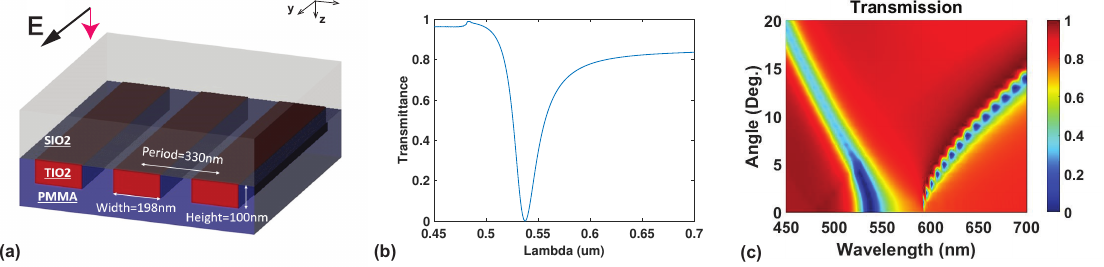
Figure 1. ( a ) Schematic of our proposed angular selective periodic grating structure optimized for selective reflection. The top encapsulating layer is silicon dioxide and the titanium dioxide grating structure is embedded in Poly(methyl methacrylate) (PMMA). Each titanium dioxide unit is 198 nm wide and 100 nm tall with a fill fraction of 0.6. The polarization of the incident electric field (black arrow labeled TE) is along the y direction and the field is propagation in the z direction (red arrow). ( b ) Transmission versus wavelength at normal incidence. It can be seen that there exist a highly reflective region around the wavelength range of 540 nm. ( c ) Plot of transmission versus wavelength at all angles of incidence. It can be seen that transmission at all angles is limited to two narrow bands, one occurring from 450–500 nm and another from 600 nm